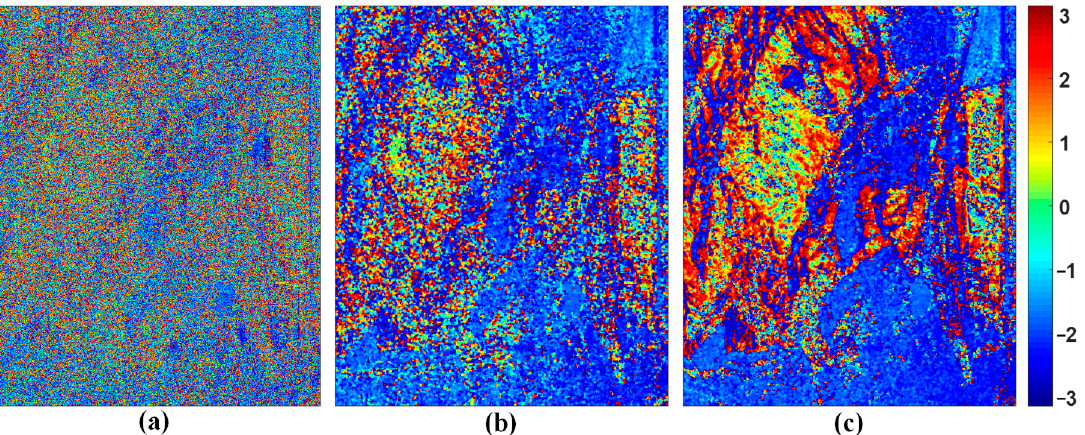
Figure 4. Estimated interferograms of the full scene between the 9th and 1st image observations. ( a ) Original interferogram in HH polarization. ( b ) Estimated interferogram in HH polarization with the Boxcar filtering. ( c ) Optimized interferogram of the proposed TSTP method.